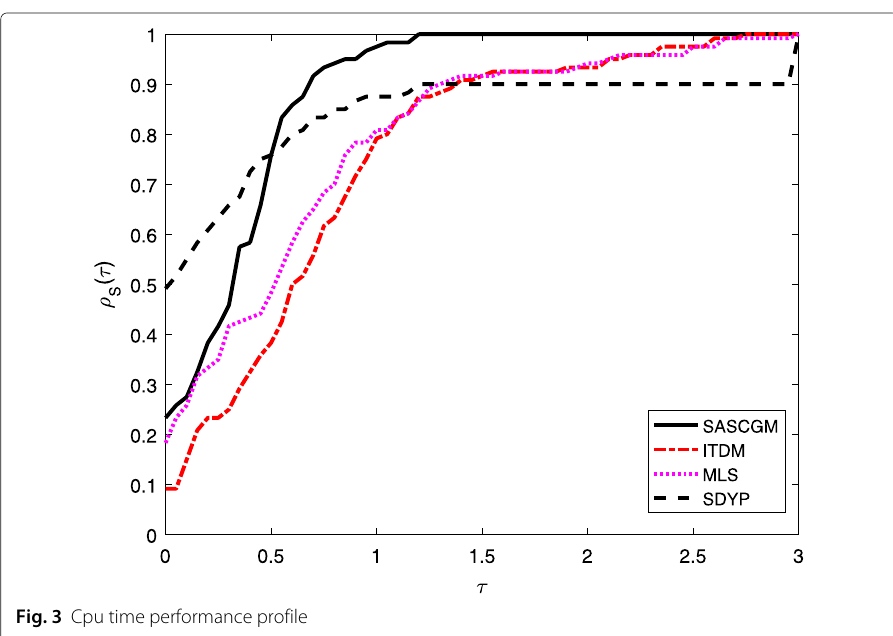
Fig. 3 Cpu time performance